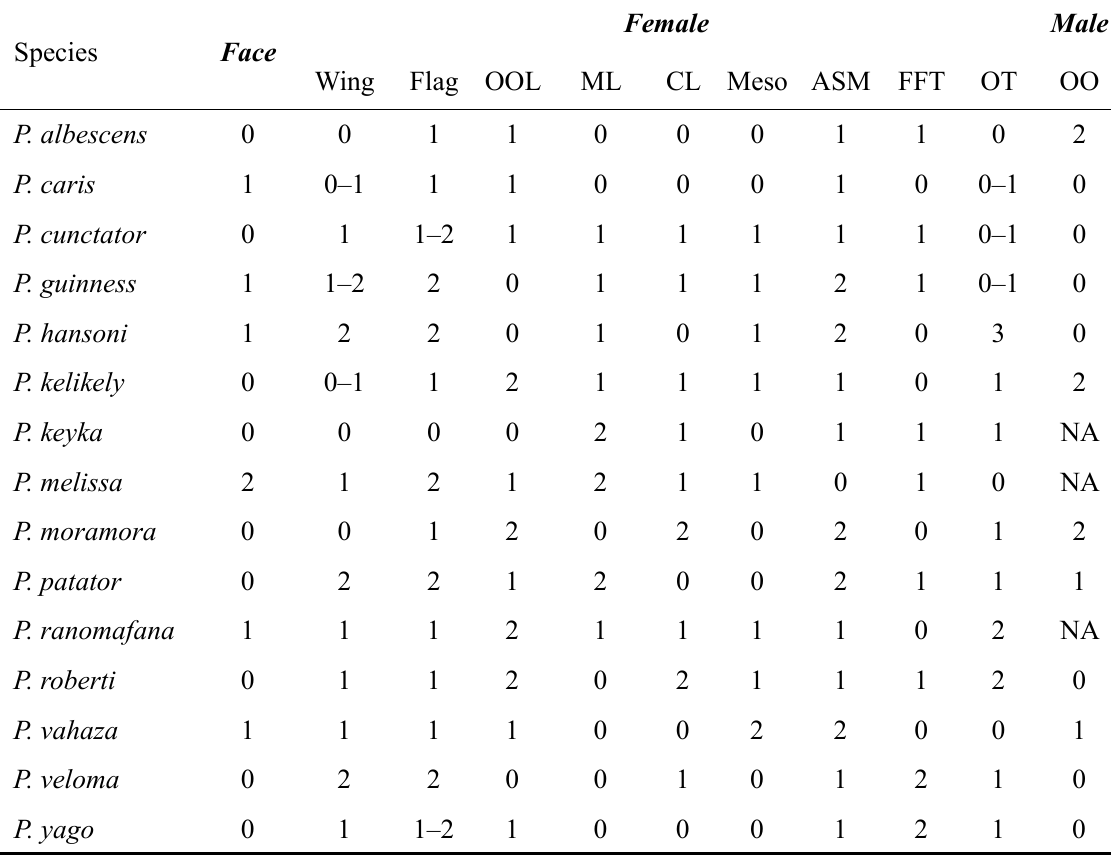
Table 1. Synoptic table for Pristomerus species of Madagascar. – Face (ground color). 0 : yellowish to orage; 1 : withish; 2 : black brown. – Female . Wing (length), 0 : < 3.6; 1 : 3.6 – 5.5; 2 : > 5.5. Flag (number of flagellomeres), 0 : < 25; 1 : 25 – 33; 2 : > 33. OOL (oculo–ocellar index), 0 : < 1; 1 : 1.0 – 1.1; 2 > 1.1. ML (Malar index), 0 : ≤ 0.5; 1 : 0.6 – 0.7; 2 :> 0.8. CL (clypeal index), 0 : < 1.7; 1 : 1.8 – 2; 2 >